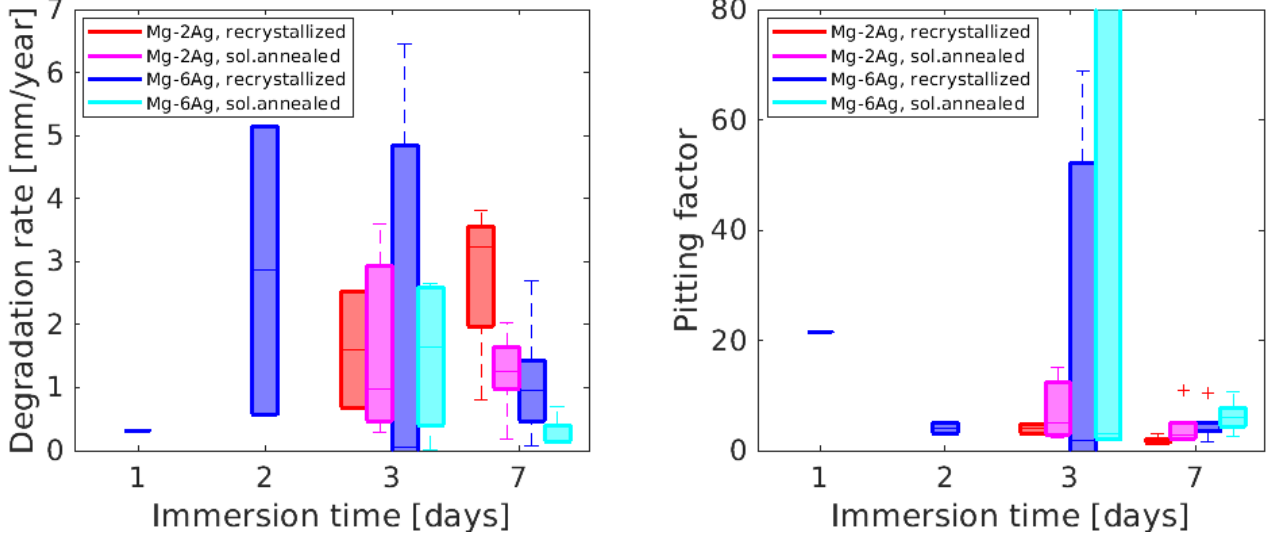
Figure 4. Degradation rate and pitting factor of Mg-2Ag and Mg-6Ag wires depending on the immersion time and treatment displayed as boxplots. The boxplots show the median of the parameters as a line and the 25th and 75th percentiles. Outliers are plotted as